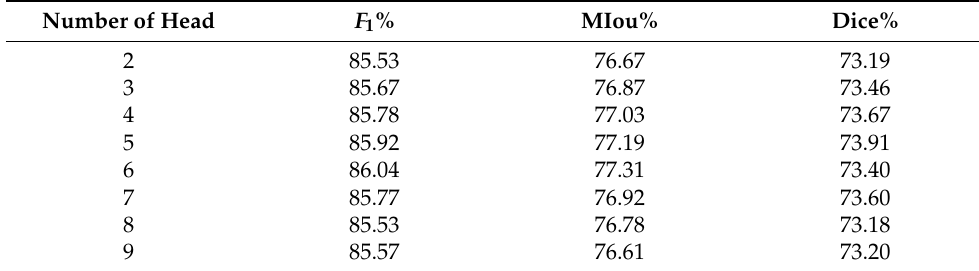
Table 3. Performances with different numbers of attention